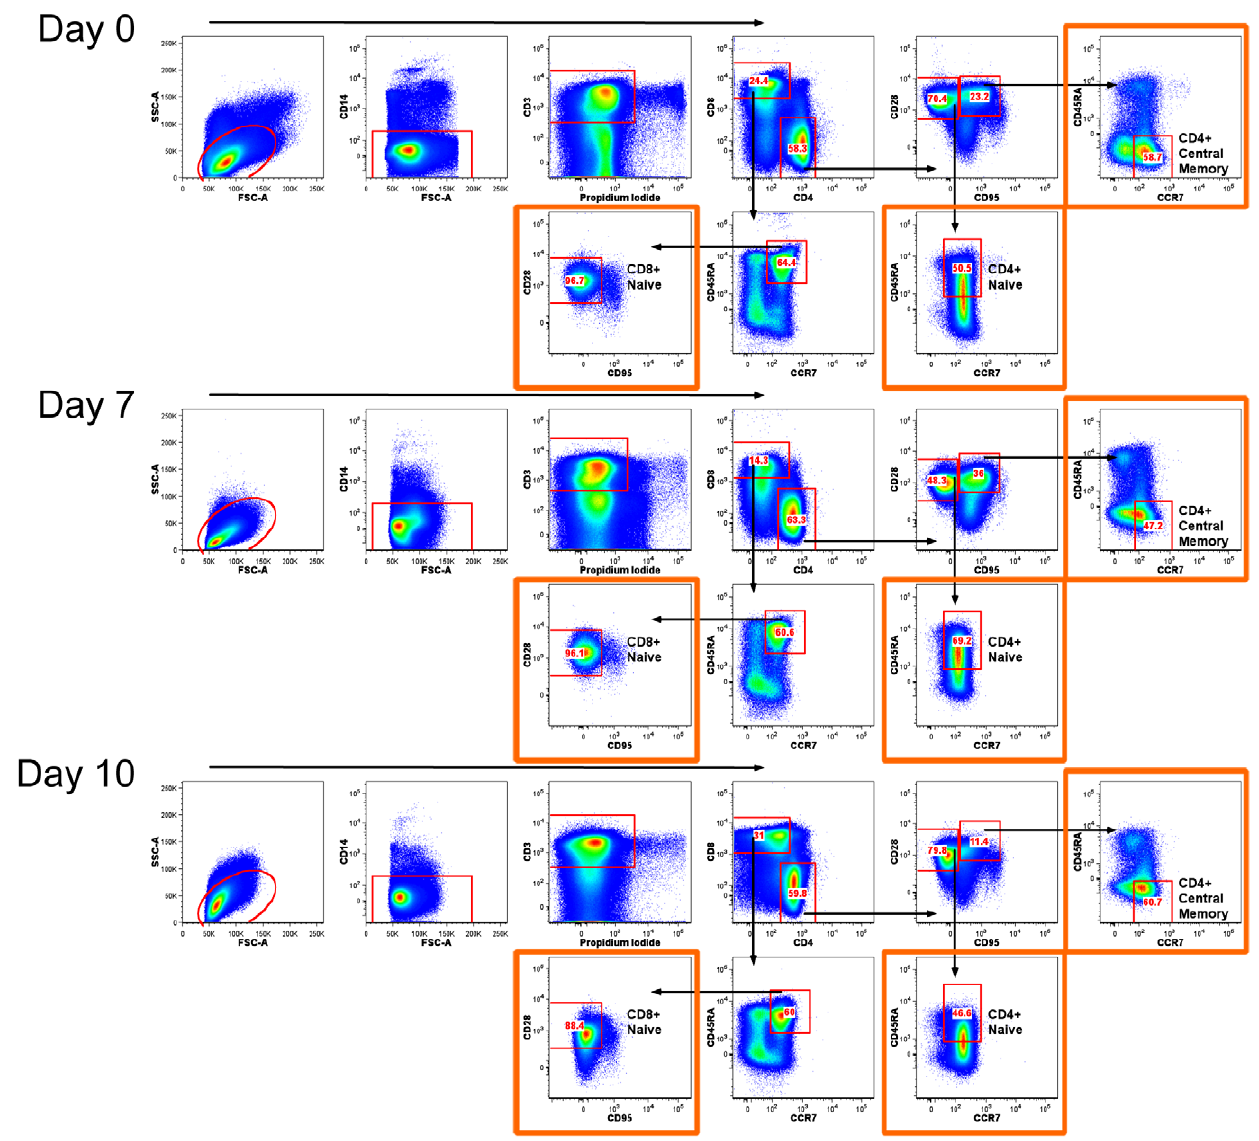
Figure 2. Cell sorting scheme. Flowcytometric cell sorting was used to isolate T cell subsets from each animal at day 0, and at day 7 and day 10 post infection. Subsets of naive and central memory CD4 + T cells and naive CD8 + T cells were sorted using markers to selectively isolate viable CD14 2 CD3 + cells subsetted as CD4 + CD28 + CD95 2 CD45RA + CCR7 + naive CD4 + T cells and CD4 + CD28 + CD95 + CD45RA 2 CCR7 + central memory CD4 + T cells and further CD8 + CD45RA + CCR7 + CD28 + CD95 2 naive CD8 + T cells (see orange highlighted box). The general phenotypic features defined by these markers were maintained over the course of the infection (day 0 – day 10). Arrows indicates the gating strategy for selecting each subset to be sorted. This is a representative figure for one of the four animals (DA9A). See Figure S2 for the profiles of all 4